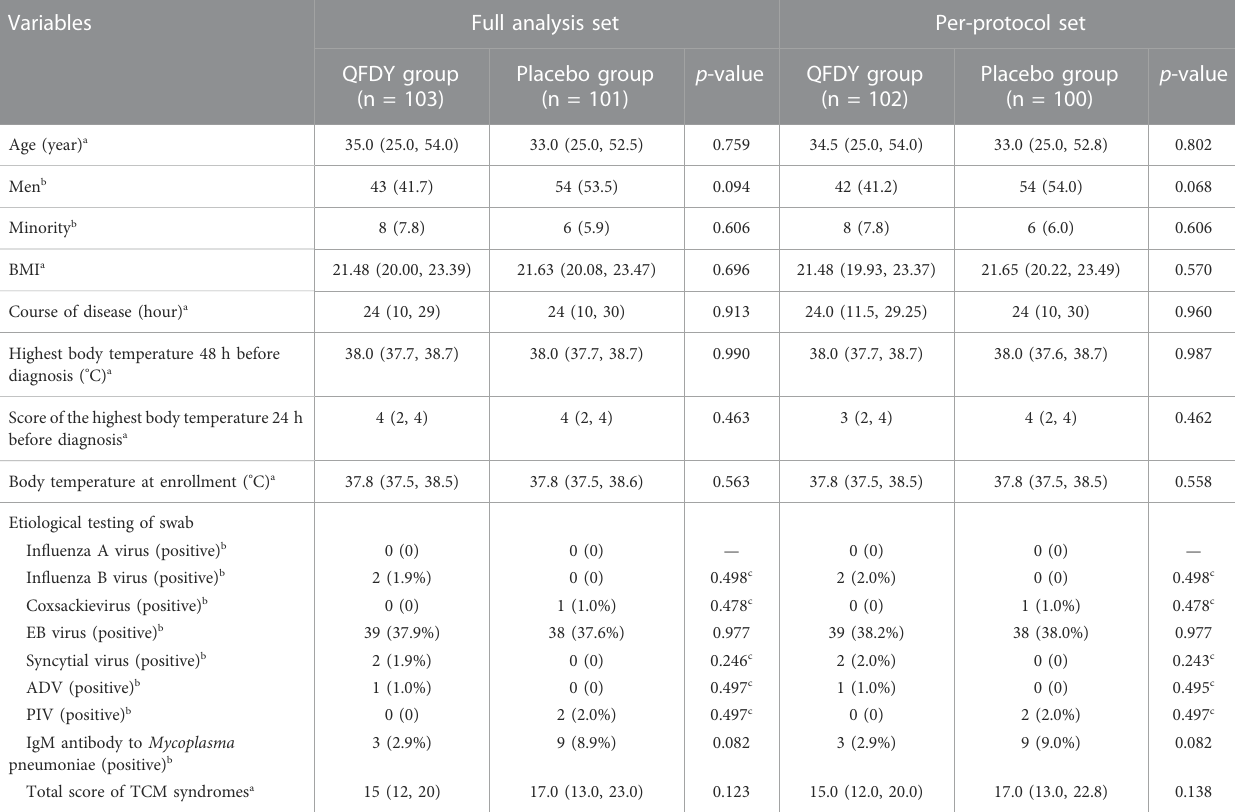
TABLE 3 Descriptive statistical